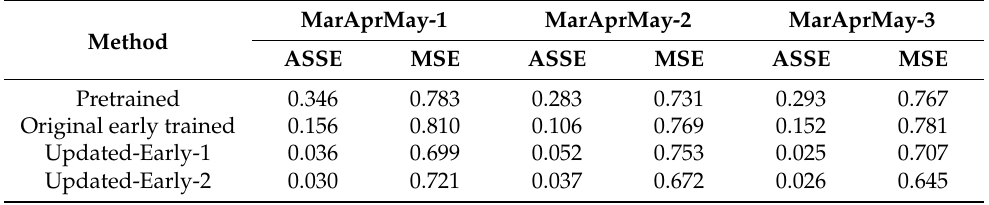
Table 4. Performance comparison on the testing data sets MarAprMay-1, MarAprMay-2, and MarAprMay-3. Smaller ASSE and MSE indicate better performance. “Pretrained” refers to the pretrained model. “Original early trained” refers to the early trained models trained by the data set Mar01. “Updated-Early-1” refers to the early trained models trained by the data set Mar01-Updated-1. “Updated-Early-2” refers to the early trained models trained by the data set